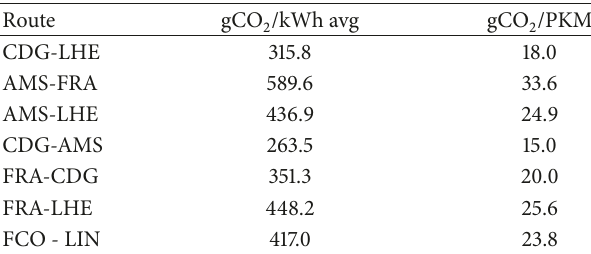
Table 8: Specific carbon intensity of each route.